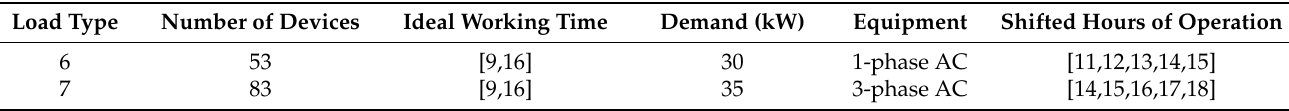
Table 7. Parameters for modeling temperature-dependent loads.